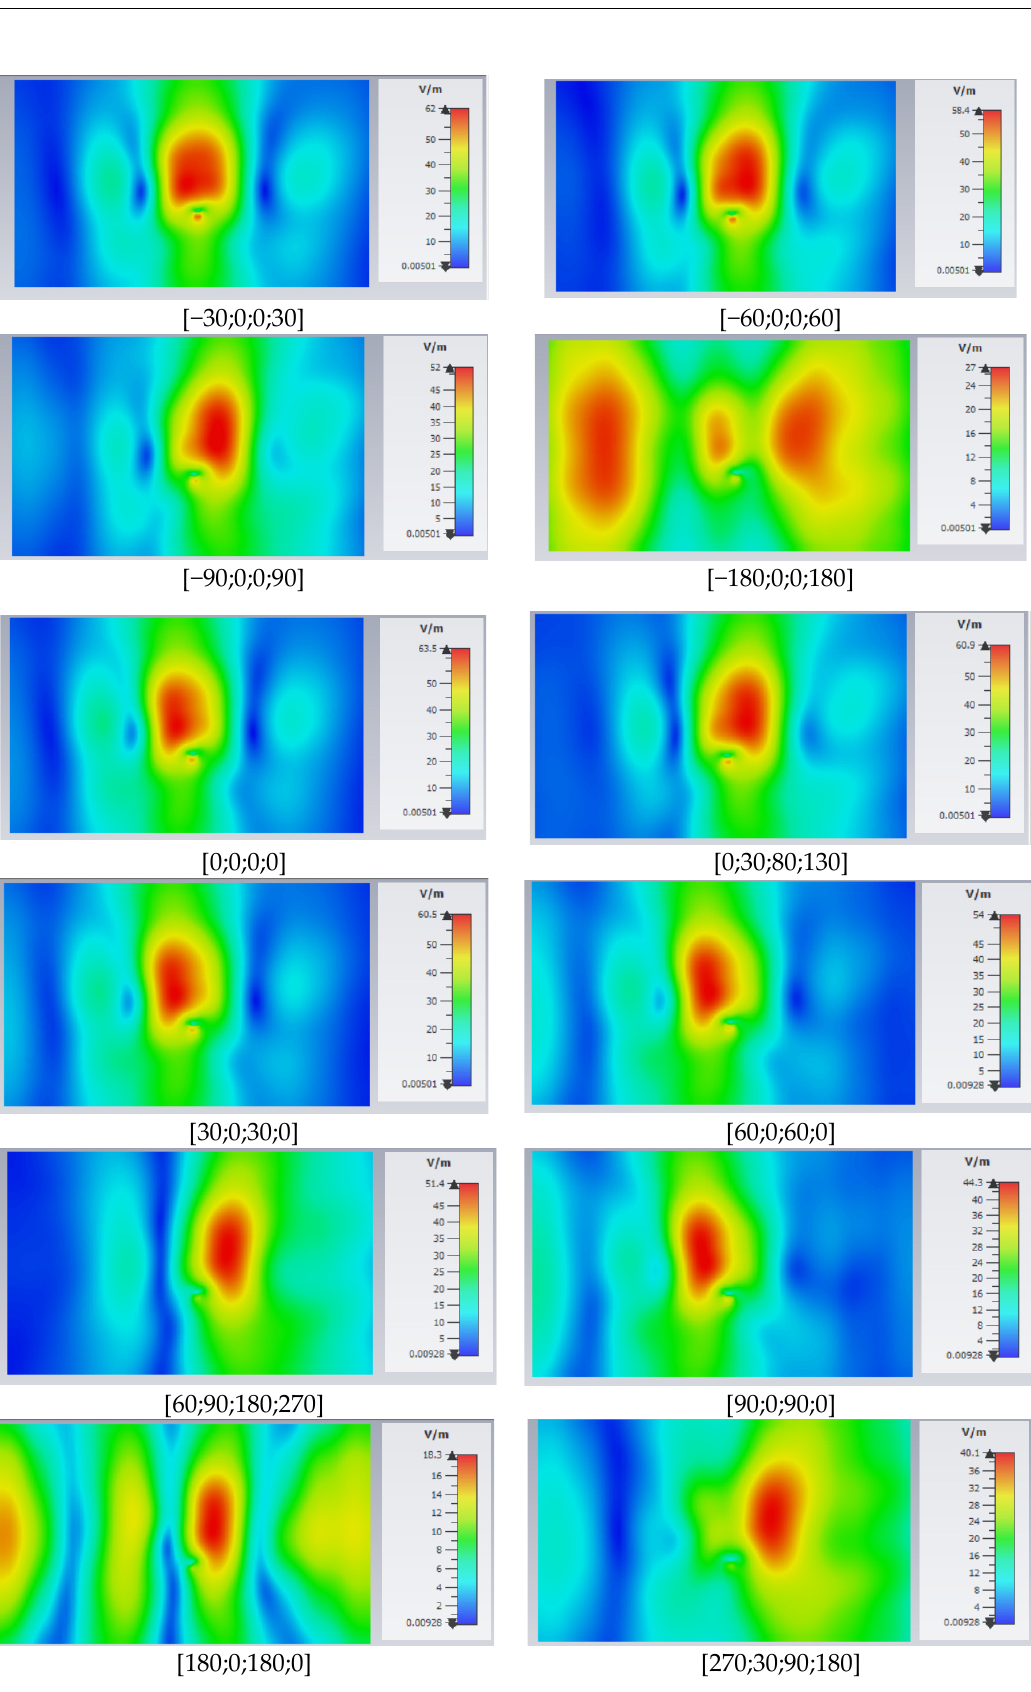
Figure 3. E-field strength distribution in a plane parallel to the 1×4 array antenna, at 20 cm away (tangent to the face of the head model) in function of the phase difference between the elements (beam steering direction).